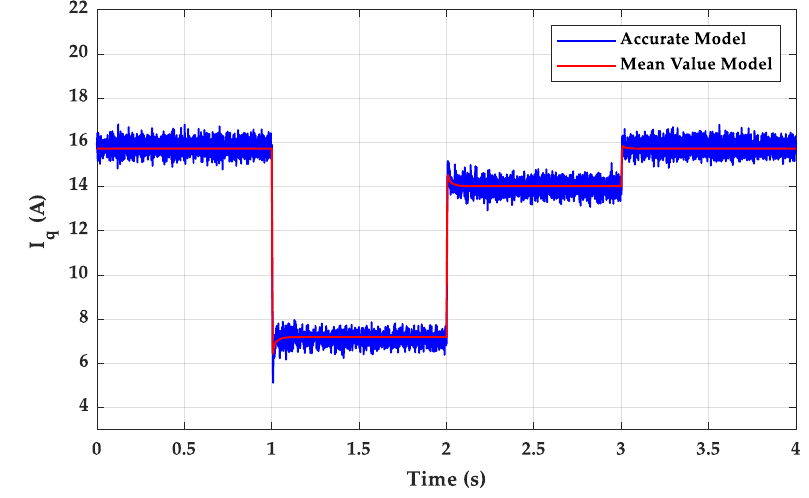
Energies 2019 , 12 , x FOR PEER REVIEW 15 of 21 Figure 4. The VSI output q-axis current component. Figure 4. The VSI output q-axis current component.